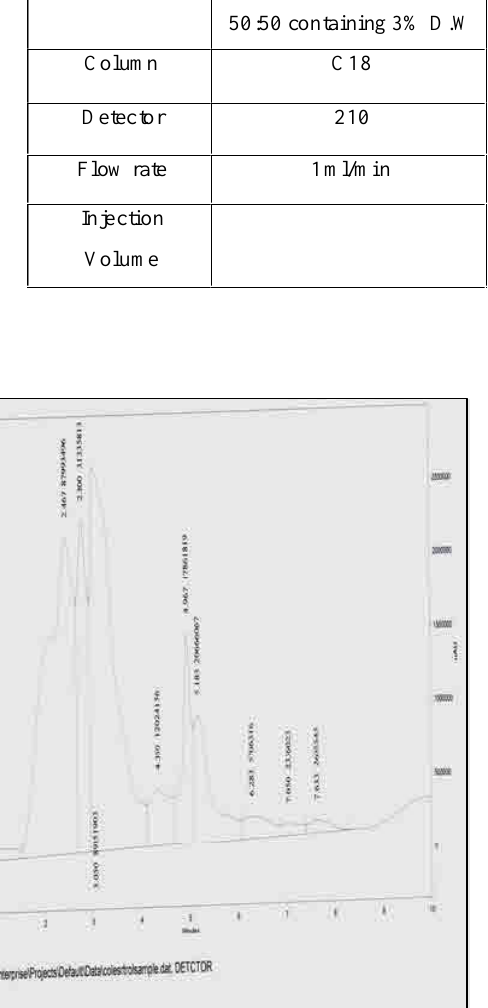
Figure (8) :HPLCchart of plant extract